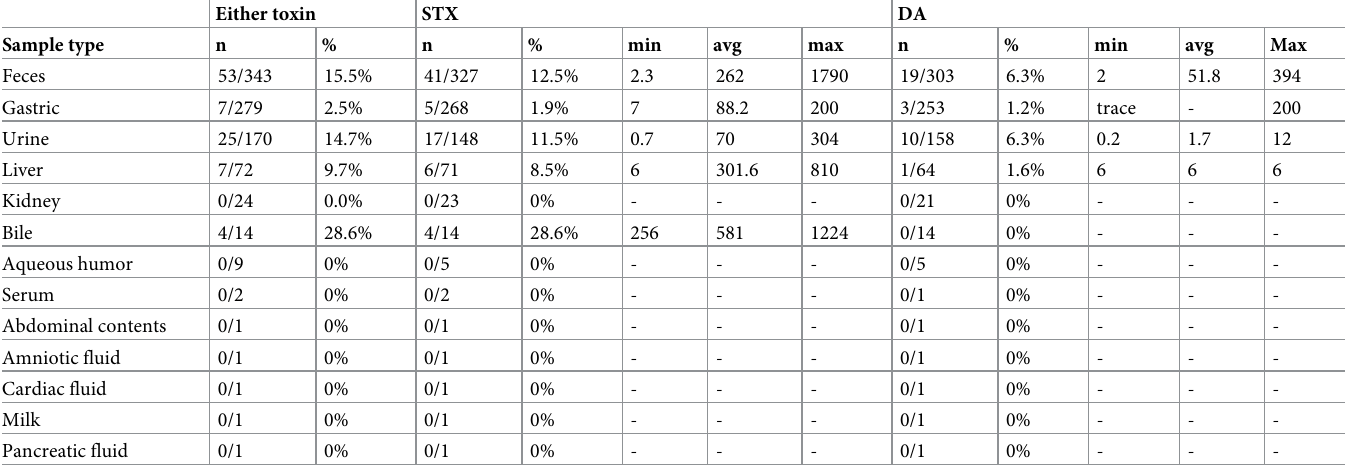
Table 7. Toxin detection frequencies and toxin concentration ranges, grouped by sample type and toxin.